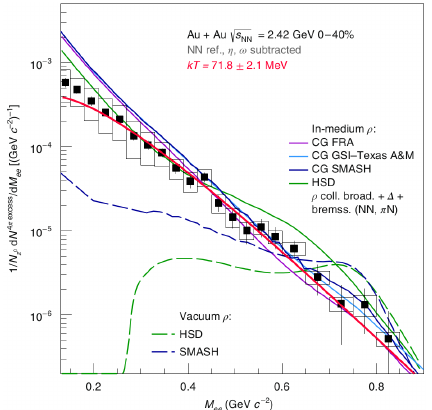
√ s NN = 2 . 42 GeV measured by